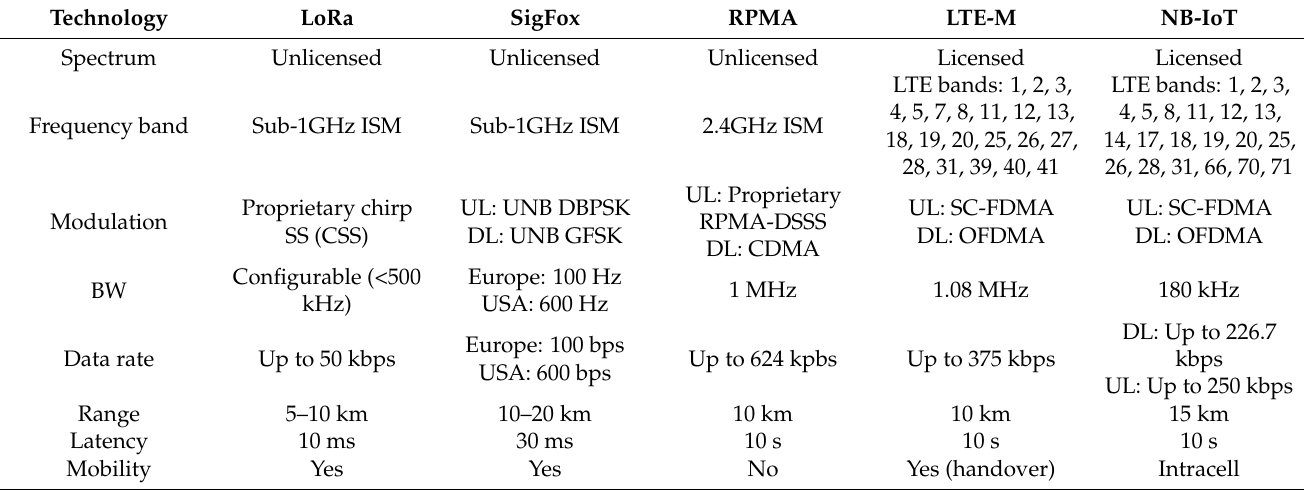
Table 1. Main features of LPWAN relevant technologies (UL: uplink, DL: downlink).